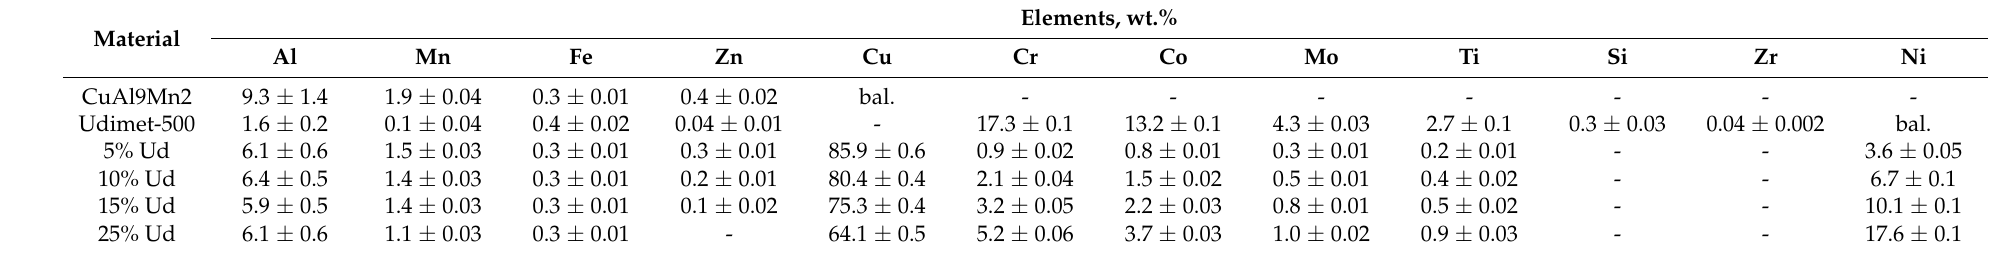
Table 1. Chemical compositions of wires and CuAl9Mn2/Udimet-500